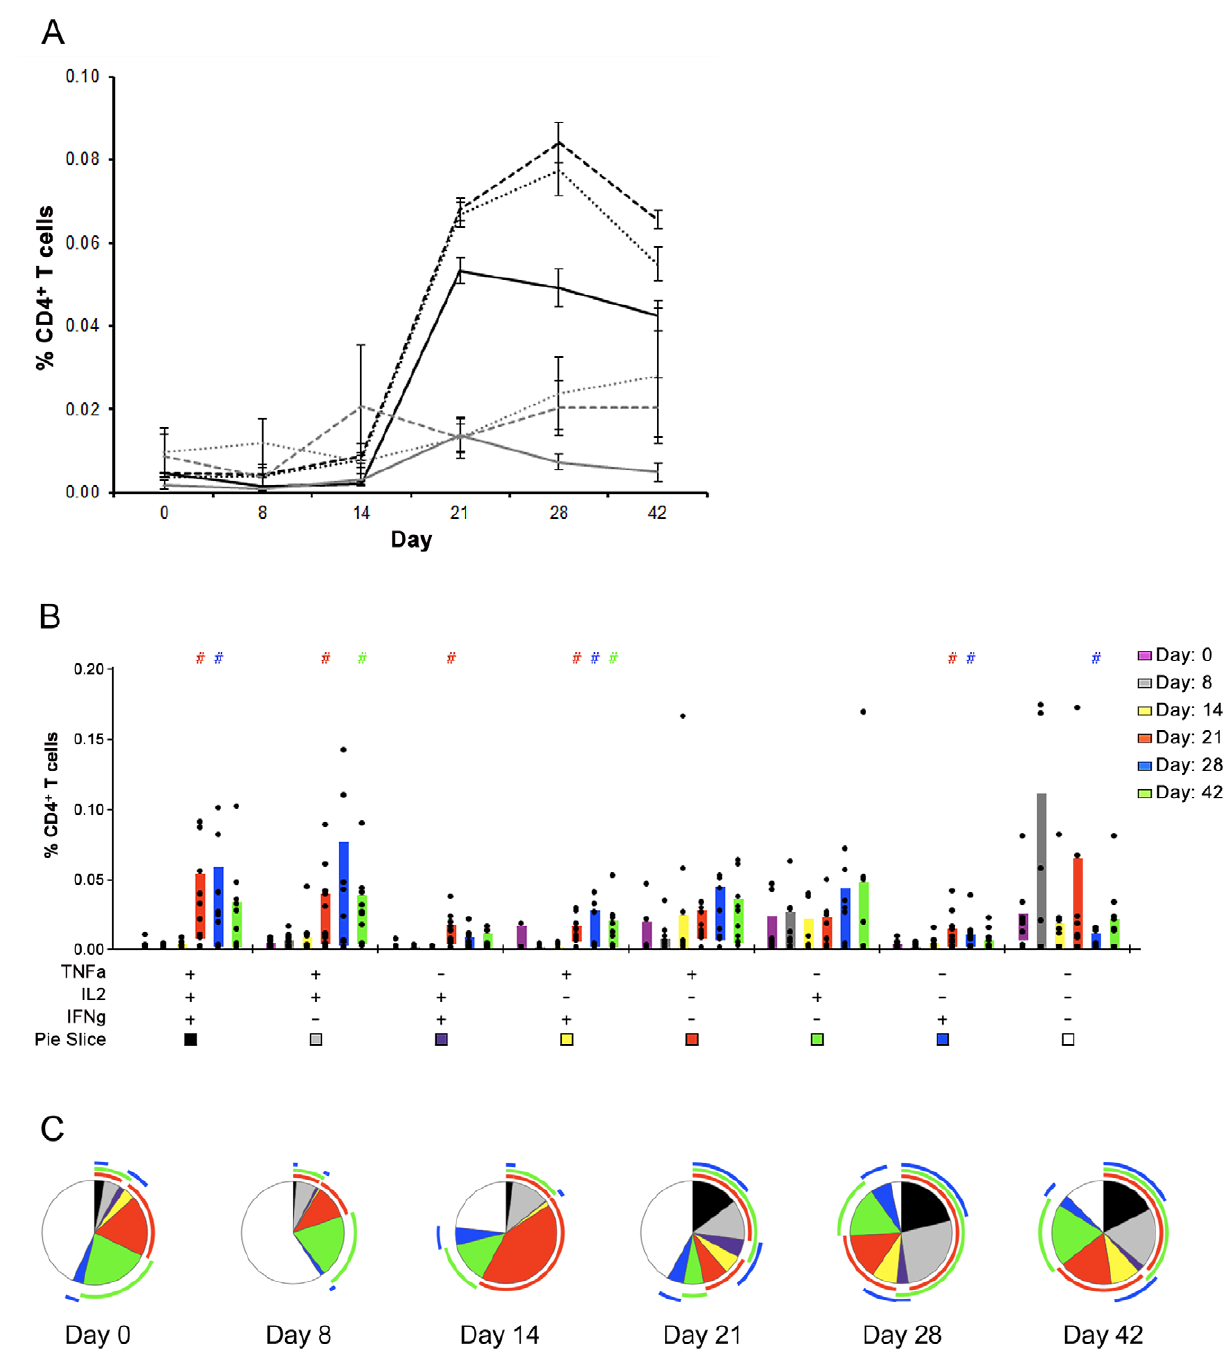
Figure 2. Multifunctional T cells are produced following exposure to 10 PFU of a DENV-1 monovalent vaccine. A. Distribution of cytokines produced by multifunctional or monofunctional T cells. The percent of multifunctional CD4 + T cells producing IFN c (black line), TNF a (black dashes), and/or IL-2 (black dots) over time relative to the number of CD4 + T cells making a single cytokine: IFN c (gray line), TNF a (gray dashes) or IL-2 (gray dots). Error bars represent standard error, n=9–11 depending on time-point. B. IFN c , IL2, and TNF a production in CD4 + T cells as a function of time and co-production. Each day is represented with a single color. Black dots correspond to the response from a single subject. Shaded bars represent the interquartile range. Line separates multifunctional T cells (left) from monofunctional T cells (right). A ‘‘ + ’’ or ‘‘ 2 ’’ indicates whether a particular cytokine (TNF a , IFN c and/or IL-2) is present. C. Proportions of total CD4 + T cells producing IFN c (blue), IL2 (green), TNF a (red), or different combinations of the three (colors indicated by boxes in B ) are shown for 5 post-vaccination time-points (days 8, 14, 21, 28, and 42) relative to pre- vaccination (day 0) for 11 vaccinees. Overlaps in red, green, and/or blue arcs indicate T cells producing the correlated cytokines simultaneously. A ‘‘ # ’’ denotes statistically a significant difference between a response on a post-vaccination day and day 0 ( p , 0.05 by Wilcoxon’s rank sum test). There are statistically higher percentages of total multifunctional T cells on days 21, 28, and 42 ( p , 0.0001).